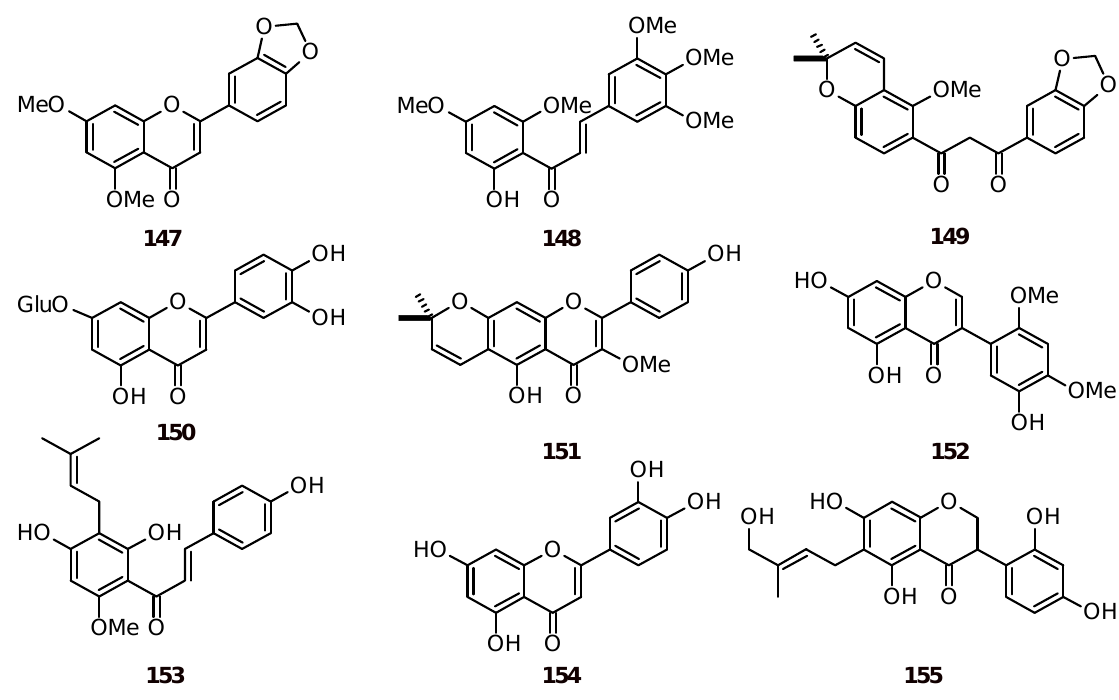
Figure 16 . Structures of flavonoids 147 - 155 .